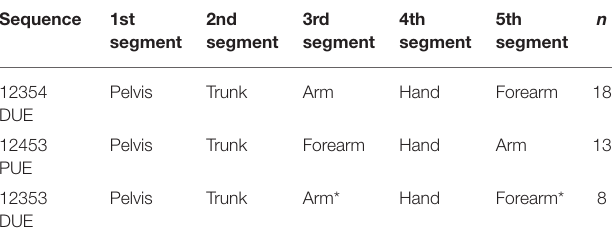
TABLE 5 | The three most performed kinematic sequences in this fastball pitch data set.